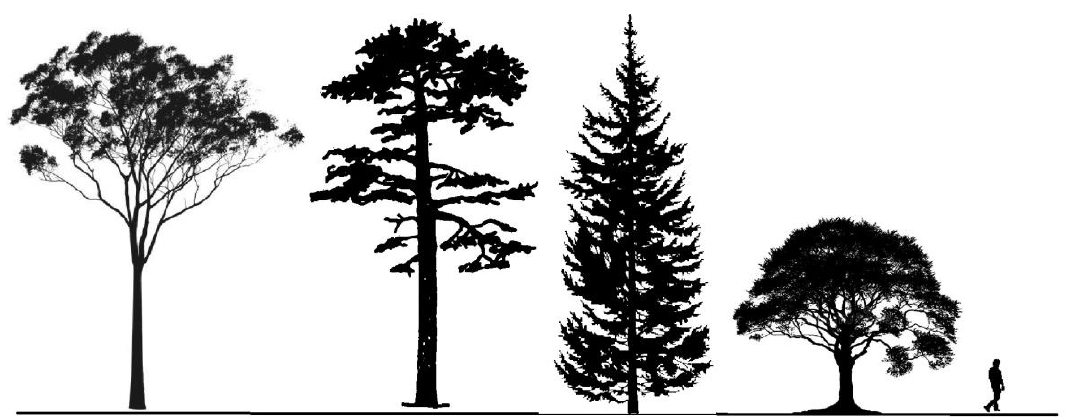
Figure 4. Different species have different morphological characteristics of the crown. From left to right: eucalyptus silhouette; red pine silhouette; Douglas fir silhouette; and oak silhouette.